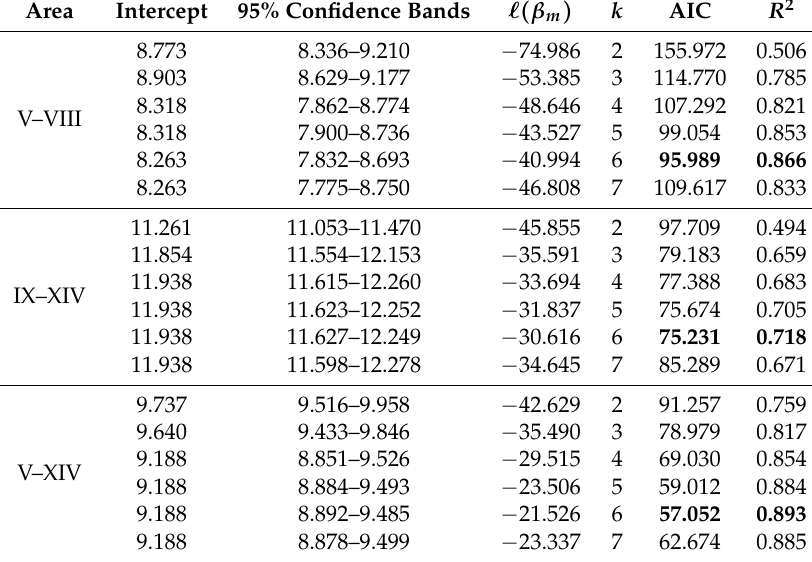
Table 1. Summary of change point models setting 1 to 6 ( k − 1) breaks, with respective log-likelihood function (cid:96) ( (cid:98) β m ) , number of parameters k , Akaike’s information criterion (AIC), and coefficient of determination R 2 . For each area, the smallest AIC and the highest R 2 are in